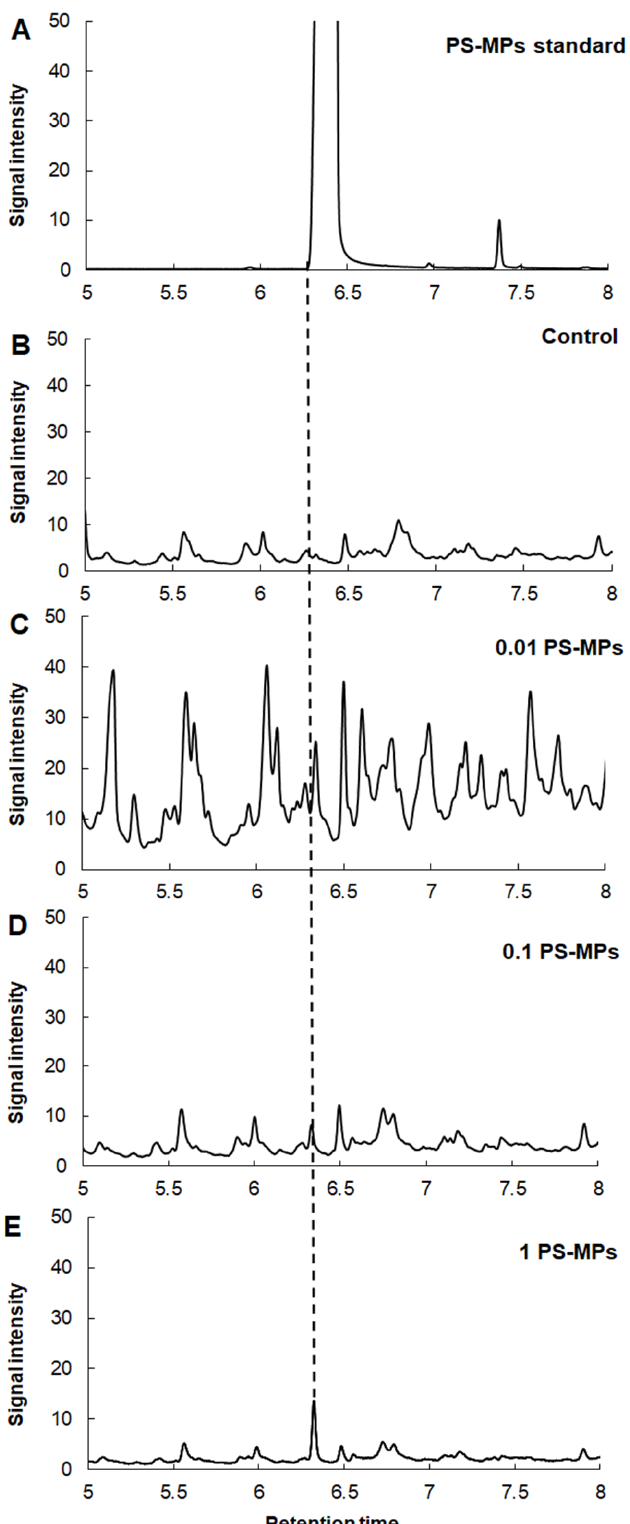
Figure 3. Extracted ion chromatogram of polystyrene monomer from pyrolysis GC-MS. Standard sample of PS-MPs ( A ); control A. cepa roots ( B ); A. cepa roots treated with 0.01 g L − 1 PS-MPs ( C ), 0.1 g L − 1 PS-MPs ( D ), and 1 g L − 1 PS-MPs ( E ).